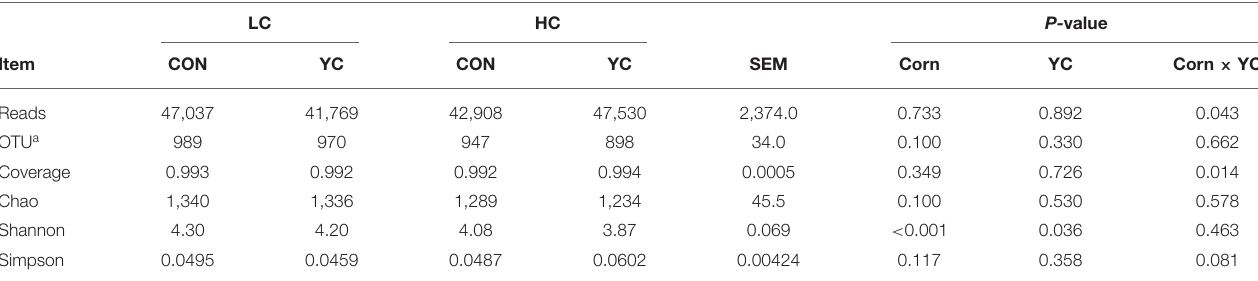
TABLE 7 | The rumen bacterial diversity of fattening lambs fed experimental diets containing a low (LC) or high (HC) proportion of corn and supplemented with nil (CON) or yeast culture (YC) ( n = 12 per treatment).